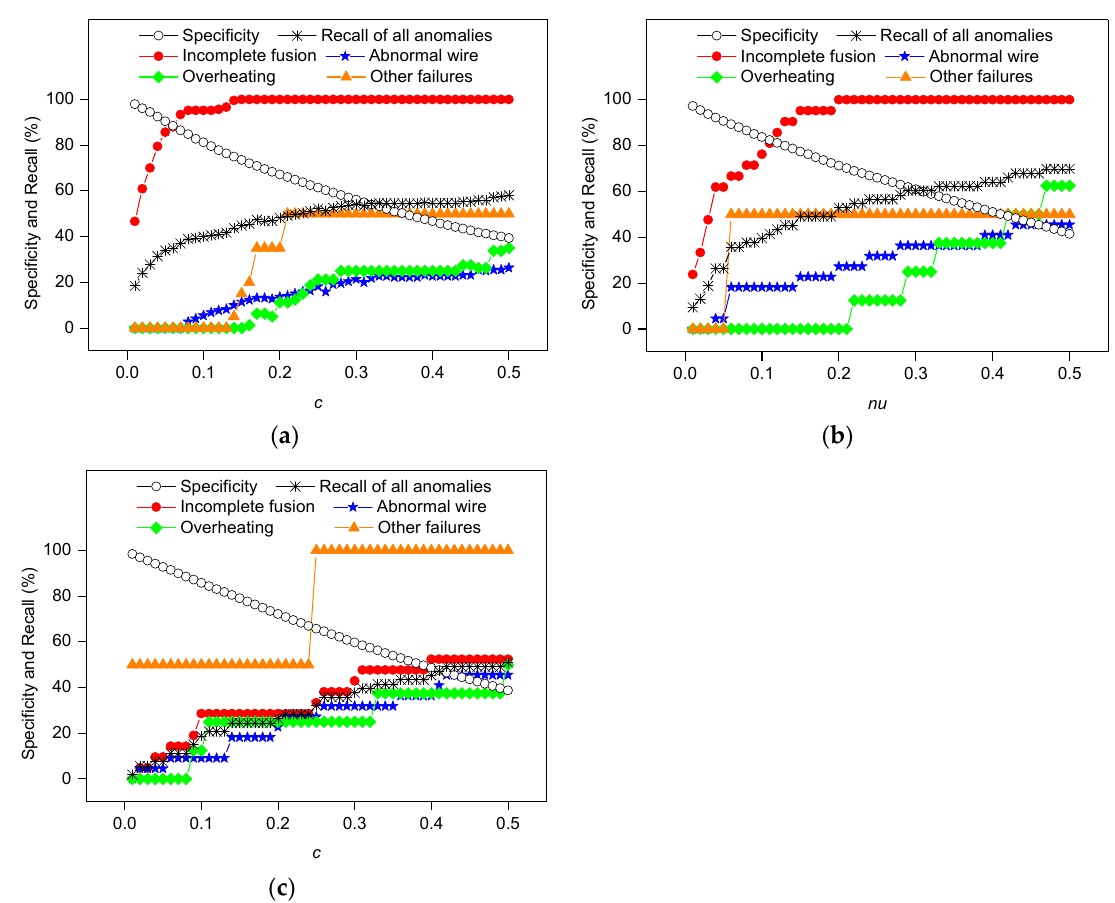
Figure 9. Comparison of detection performance: ( a ) iForest, ( b ) OCSVM; ( c ) LOF.